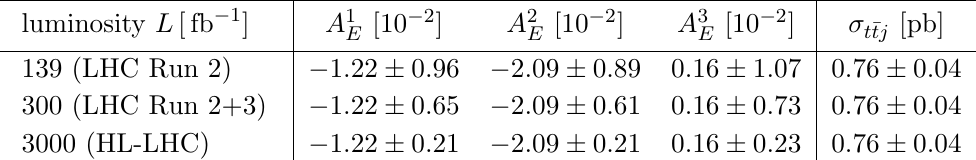
in three (cid:18) j bins and for the E p s = 13 TeV. The quoted errors are the